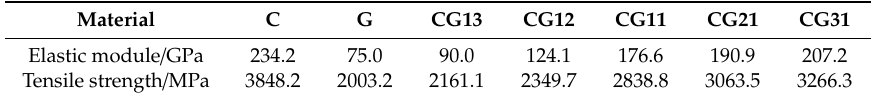
Table 5. Material parameters of HFRP.